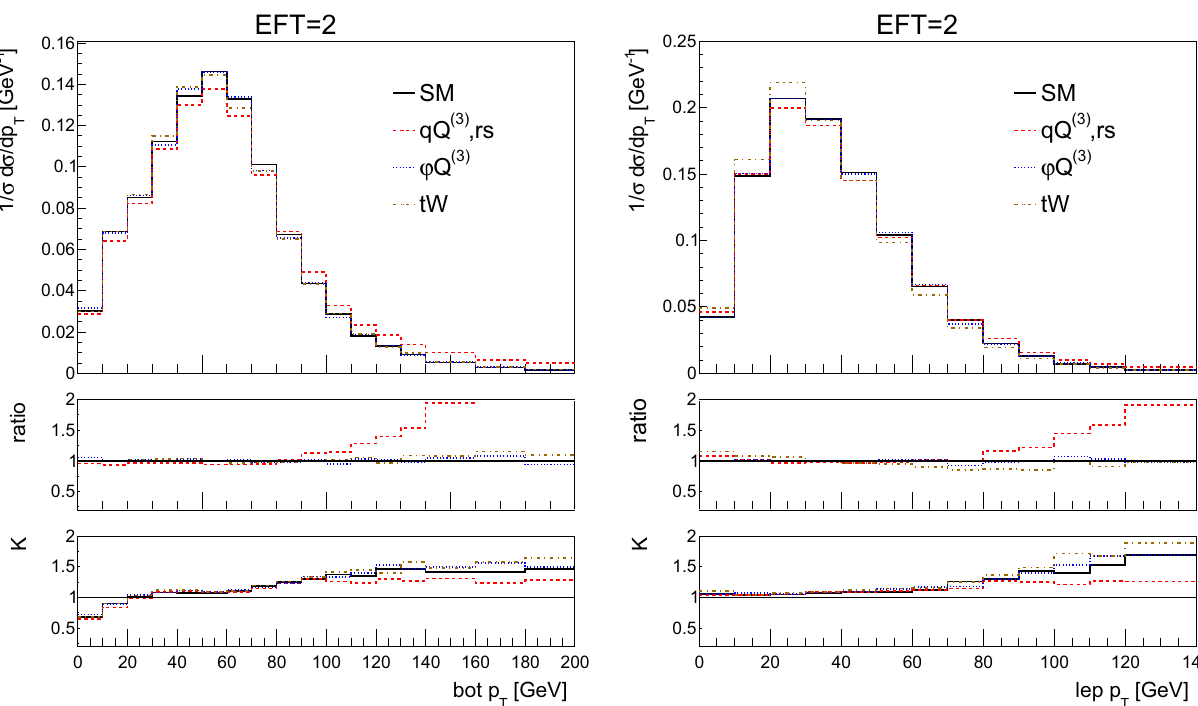
Fig. 12 The NLO distributions of the b − jet (left) and electron (right) transverse momentum for the SM and the three effective operators of interest for the couplings values of Table 2. The ratio shown in the first inset is defined as the effect of the operator over the SM, the second inset shows the K -factor